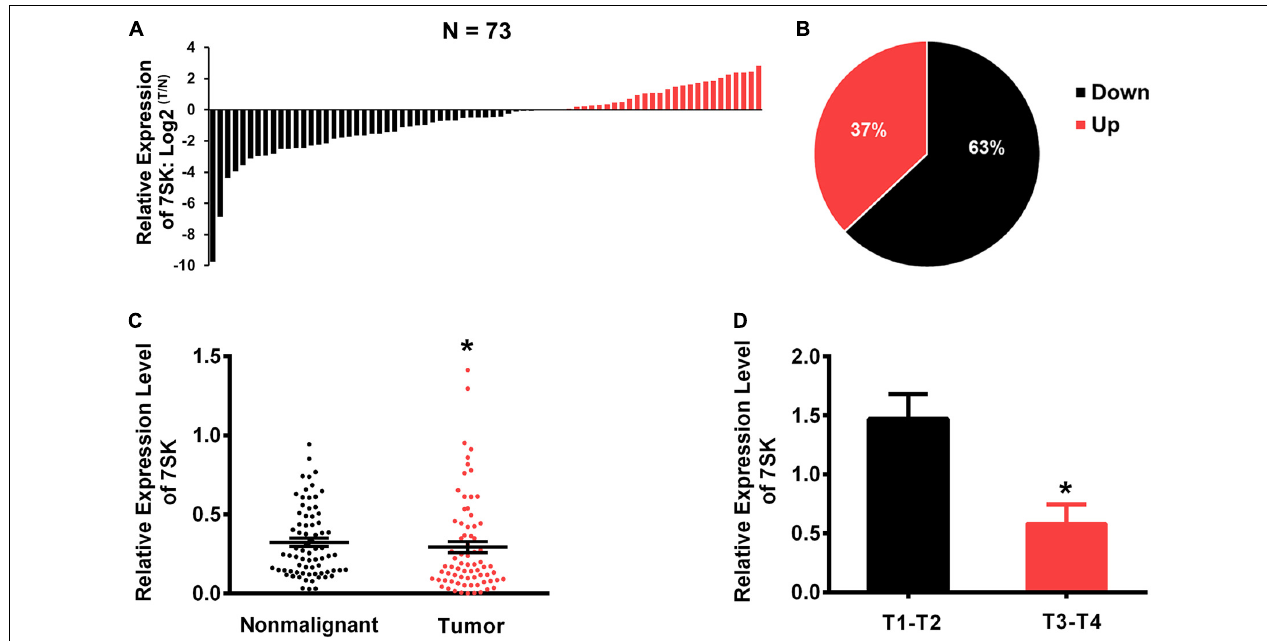
FIGURE 1 | The expression levels of 7SK in TSCC patients. (A) The Log 2 fold changes of 7SK expression (in tumors and non-malignant samples) in each of 73 TSCC patients. (B) Pie chart showing ratios of different 7SK expression in tumors and non-malignant areas of 73 patients. (C) Scatterplot showing the expression levels of 7SK in 73 TSCC tumors and the corresponding non-malignant samples. (D) The expression levels of 7SK in different T stages of the 73 patients. * P <